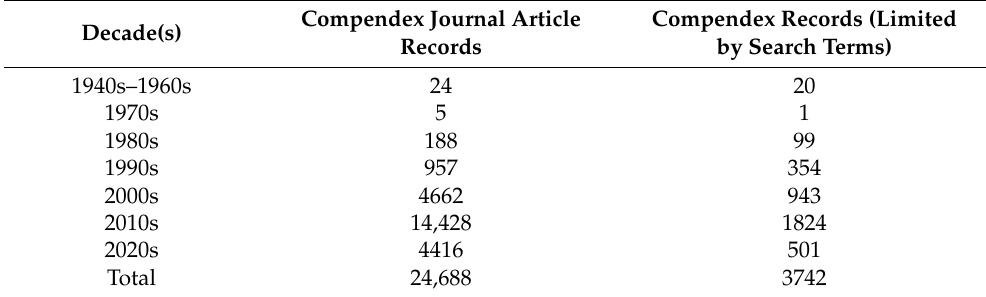
Table 1. Three-dimensional (3D) product model journal articles in English from Compendex records by